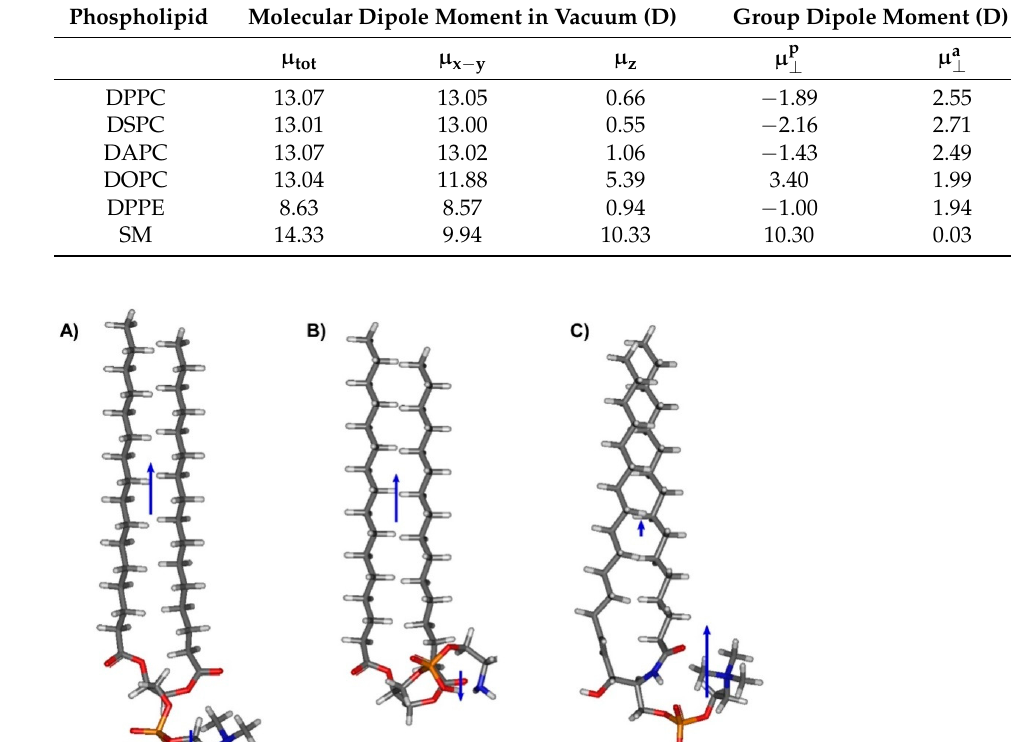
Table 3. Values of apparent dipole moments calculated from Equation (4) using the set of values of ( μ (cid:2884) (cid:2933) /ε (cid:2933) ), ε (cid:2926) and ε (cid:2911) equal to (1) 0.04; 7.6 and 5.3 (according to [16]); (2) − 0.065; 6.4 and 2.8 (according to [18]); (3) 0.04; 7.6; 4.2 (according to